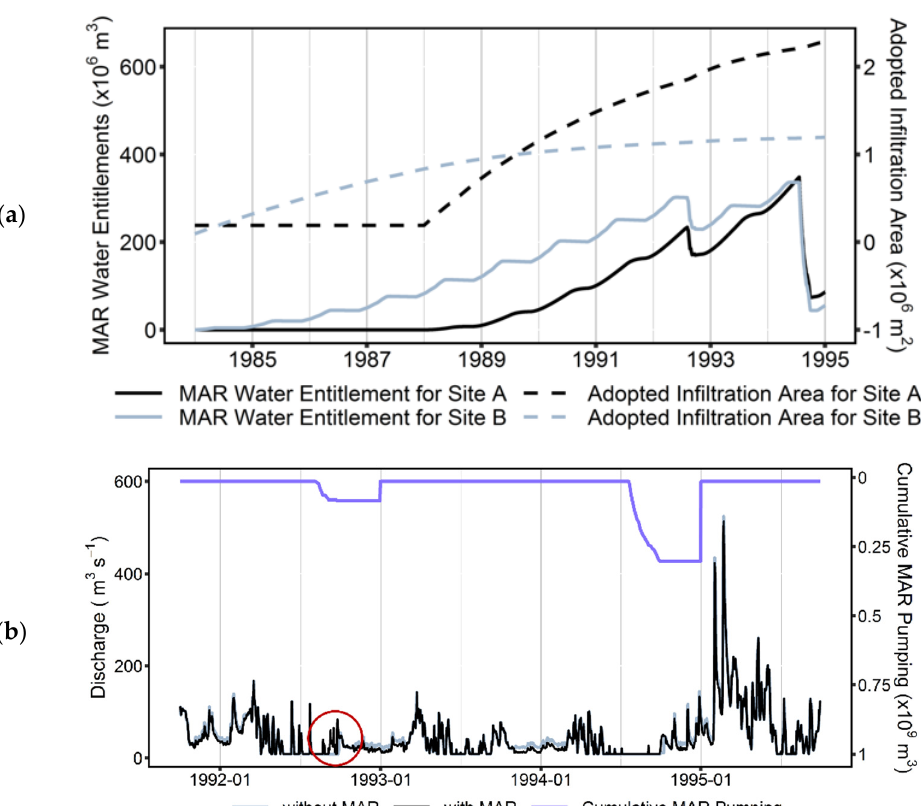
Figure 14. ( a ) Cumulative MAR water entitlement and adopted infiltration area; ( b ) instream flow for Site A scenario and No MAR implementation scenario during water year 1992–1995. Cumulative MAR pumping shows annual MAR pumping for Site A scenario.